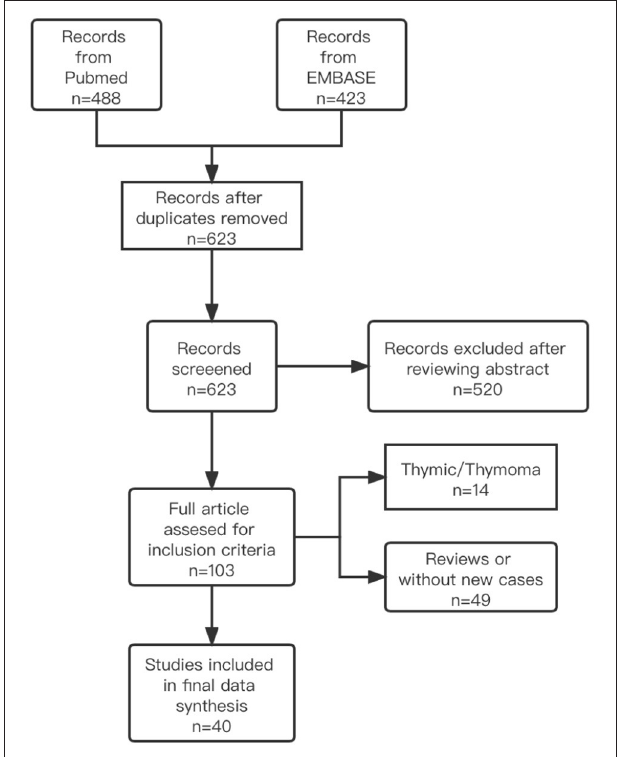
FIGURE 1 | Flow gram describing the systematic search and study selection